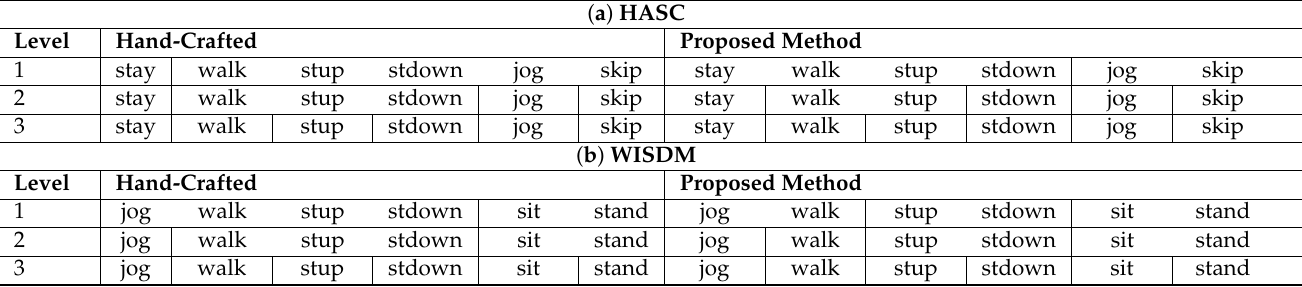
Table 5. Manually designed class hierarchies for HASC and WISDM and class hierarchies designed by the proposed